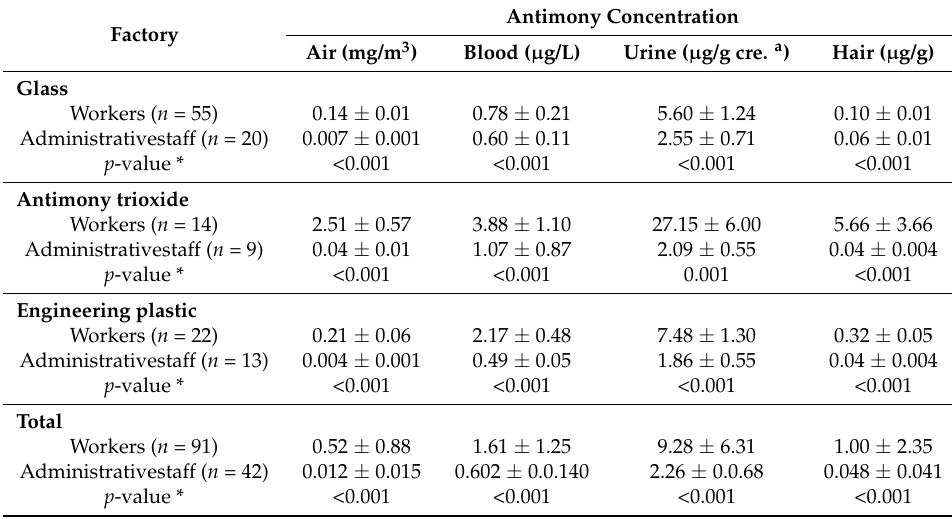
Table 2. Average antimony concentrations in samples of air, blood, urine, and hair of metal-exposed workers and administrative staff by type of